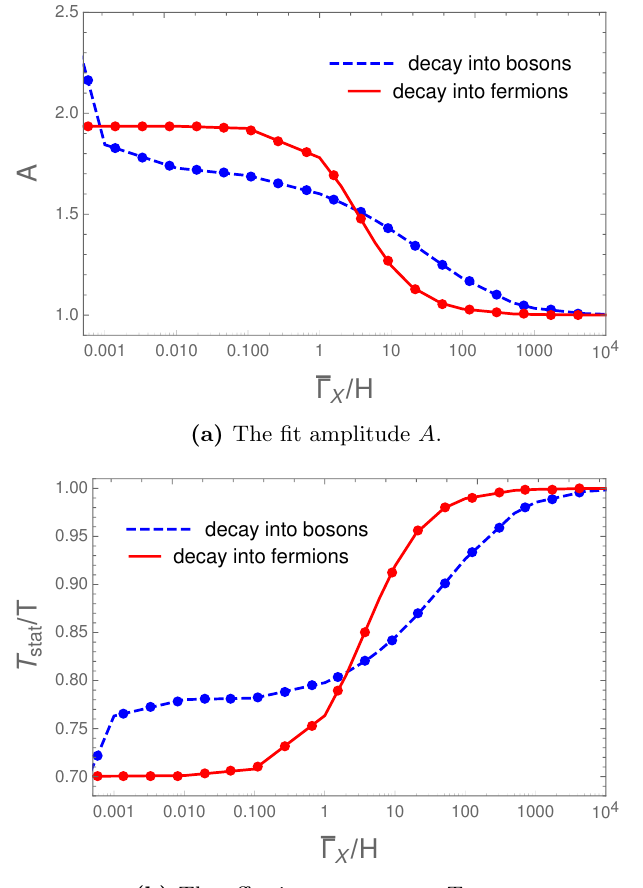
Figure 3. The (cid:12)tting amplitude A (a) and e(cid:11)ective temperature T stat (b) for the stationary distribution with m X = 0 : 001 T . Dashed lines are for the case of decay into bosons, while solid lines are for the case of decay into